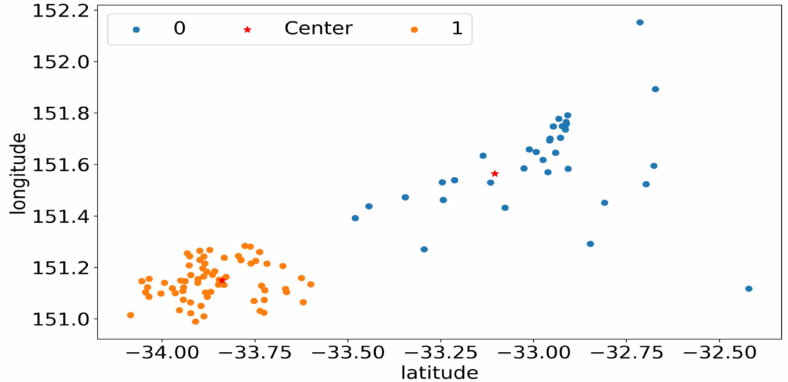
Figure 8. Result of rooftop PV in Australia clustering.